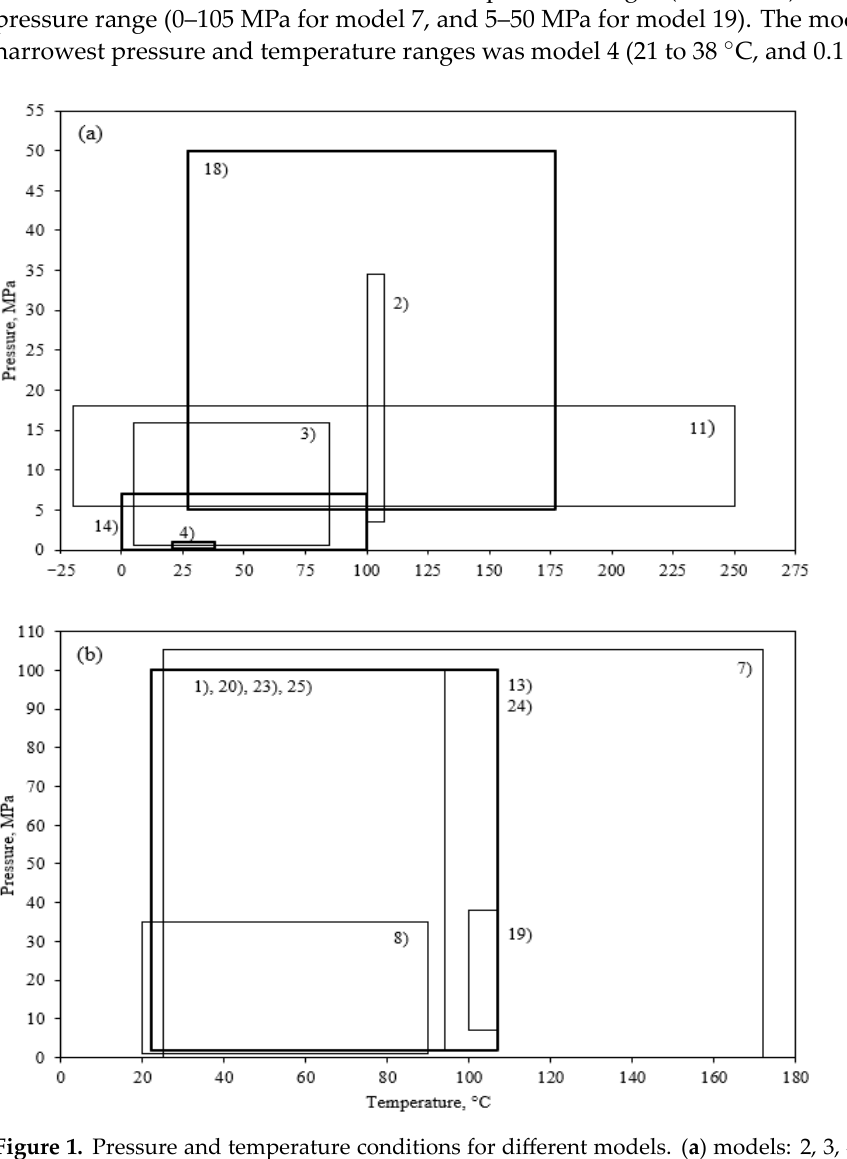
Figure 1. Pressure and temperature conditions for different models. ( a ) models: 2, 3, 4, 11, 14, and 18. ( b ) models: 1, 7, 8, 13, 19, 20, 23, 24, and 25 .